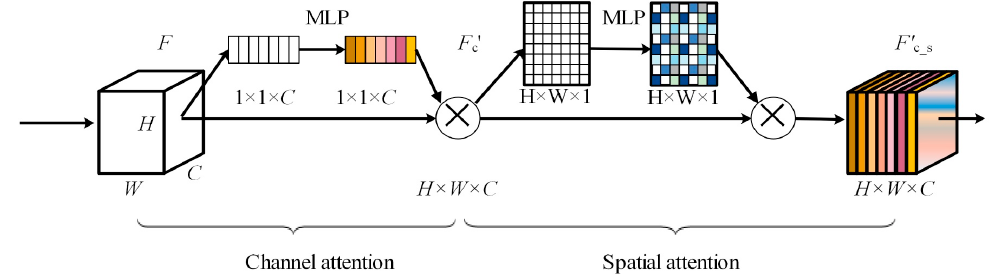
Figure 4. Overview of the channel and spatial attention mechanism used in this study. F represent the original feature maps. H, W, C represent the height, width and channel number of the feature maps, respectively. MLP represents the multi-layer perception with one hidden layer. F c ’ represent the channel refined feature maps. ′ ⊗ ′ represents the element-wise multiplication. F ’ c_s represent the final channel and spatial refined feature maps.